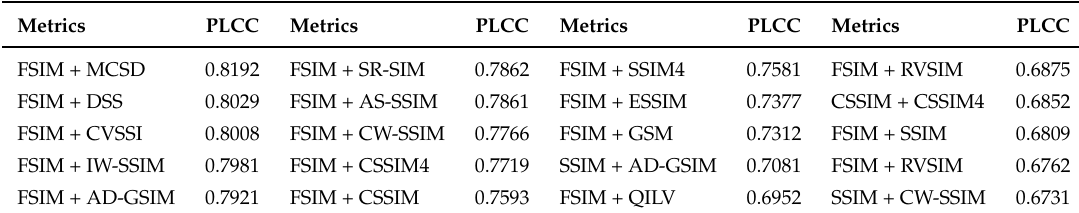
Table 2. The PLCC values obtained for 107 images using 25 “best” combinations of two elementary metrics assuming the division into 16 regions.